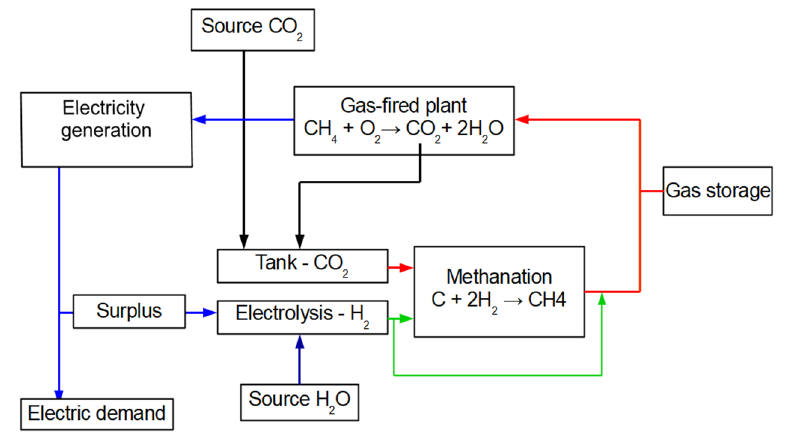
Figure 4. Power-to-gas scheme based on a natural gas combined cycle (NGCC).